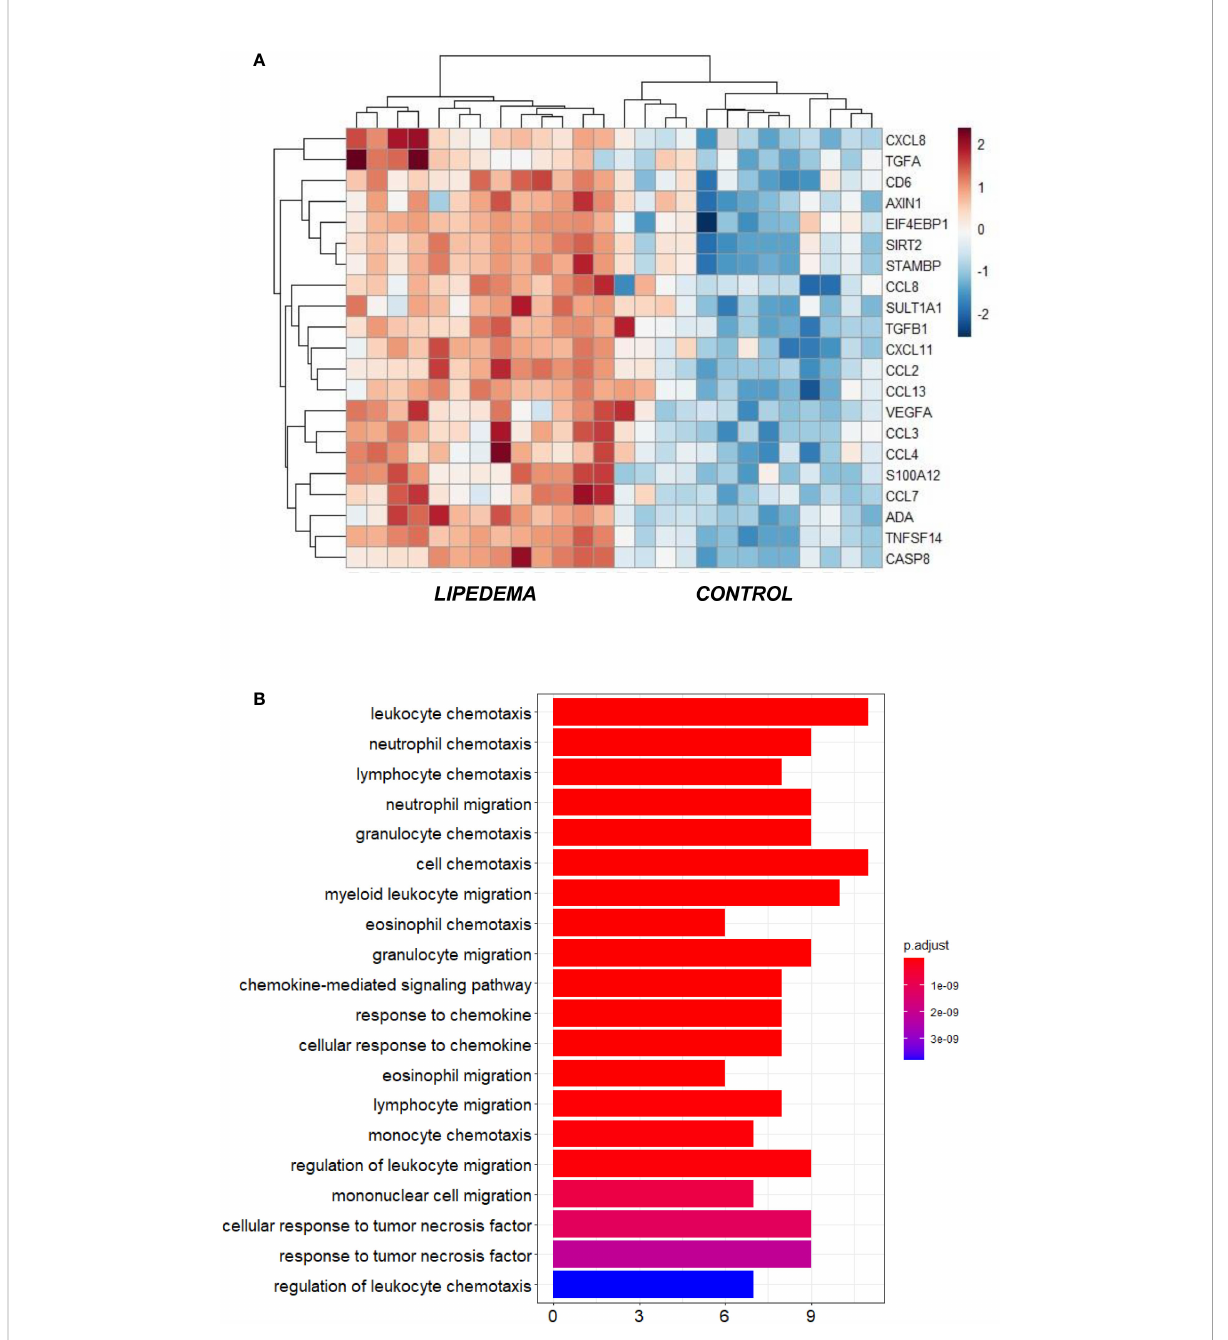
FIGURE 2 (A) Heatmap visualization of the signi fi cantly different in fl ammatory protein expression in plasma samples of lipedema compared to age- and BMI-matched control group (p_adj < 0.05); (B) Gene ontology enrichment analysis presenting the top 20 biological processes (GO terms) enriched by the differential expressed plasma in fl ammatory proteins between lipedema and control